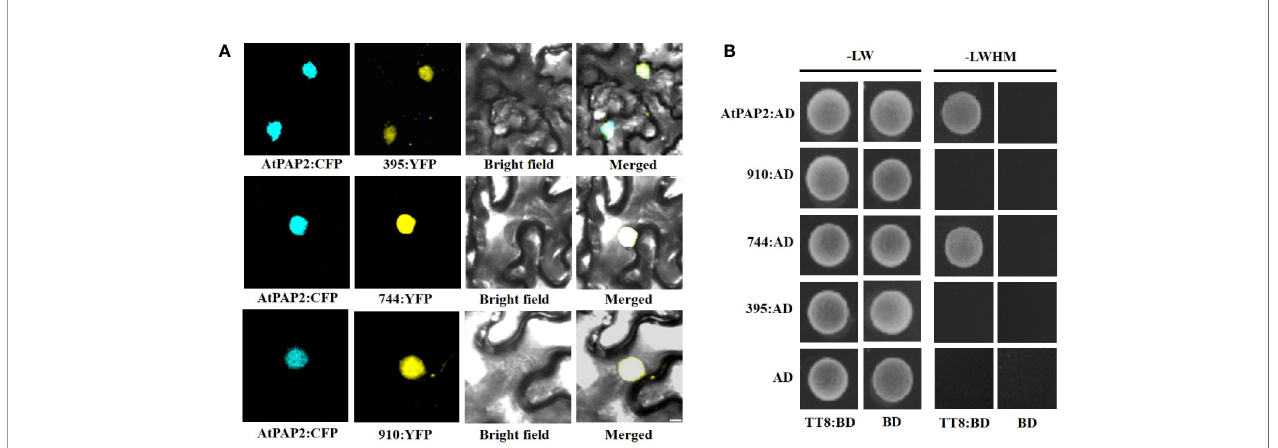
FIGURE 6 | Subcellular localization of proteins encoded by three isoforms and their ability to bind to bHLH protein revealed by Yeast two-hybrid analyses. (A) BiFC interaction assays of BnaPAP2.A7-395, BnaPAP2.A7-744, and BnaPAP2.A7-910 with AtPAP2. Partial YFP fusion constructs were expressed transiently in N. benthamiana leaves. AtPAP2-CFP was used as a known nuclear marker. Scale bar: 100 m m. (B) Yeast two-hybrid analyses of interactions between three transcripts and AtTT8. 395: BnaPAP2.A7-395; 744: BnaPAP2.A7-744; 910: BnaPAP2.A7-910. LW: Leucine and Tryptophan; LWHM: Leucine, Tryptophan, Histidine and